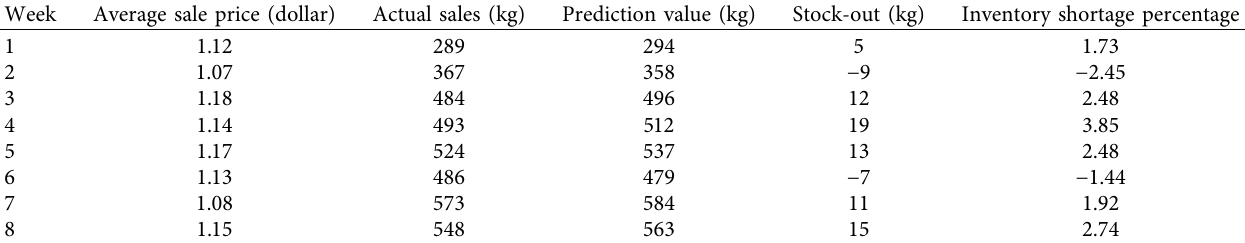
Table 3: Actual sales and forecast value of online consumption demand of rice in 8 weeks.